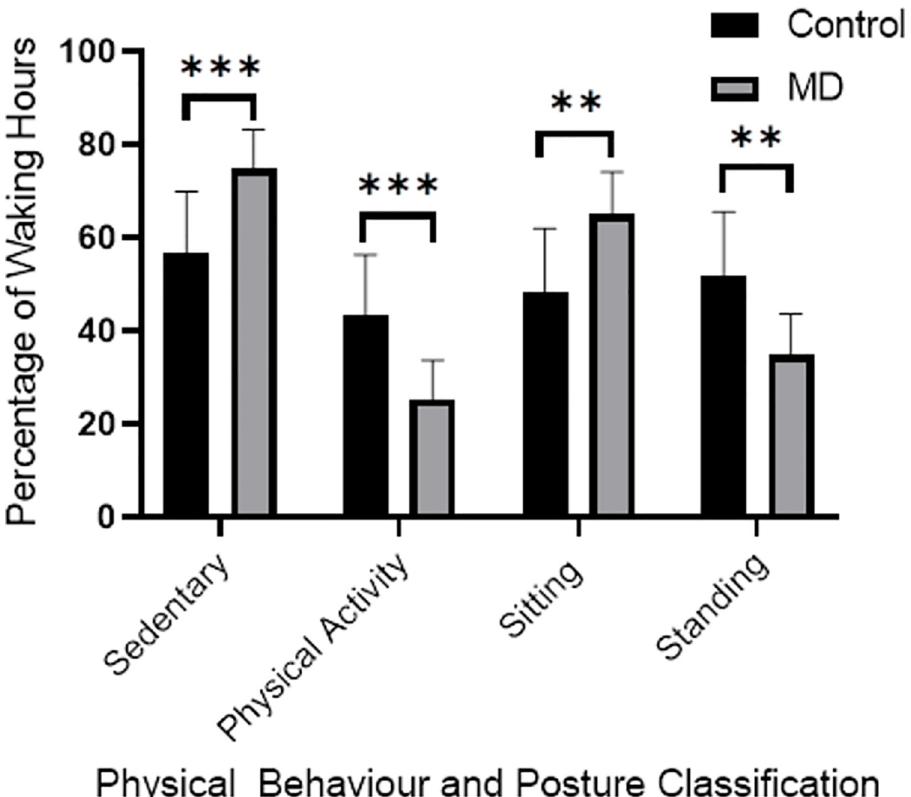
Fig 1. Daily physical behaviour and posture classification relative to waking hours (%). MD = Muscular Dystrophy, CTRL = Control, �� = p < 0.01, ��� = p < 0.001.